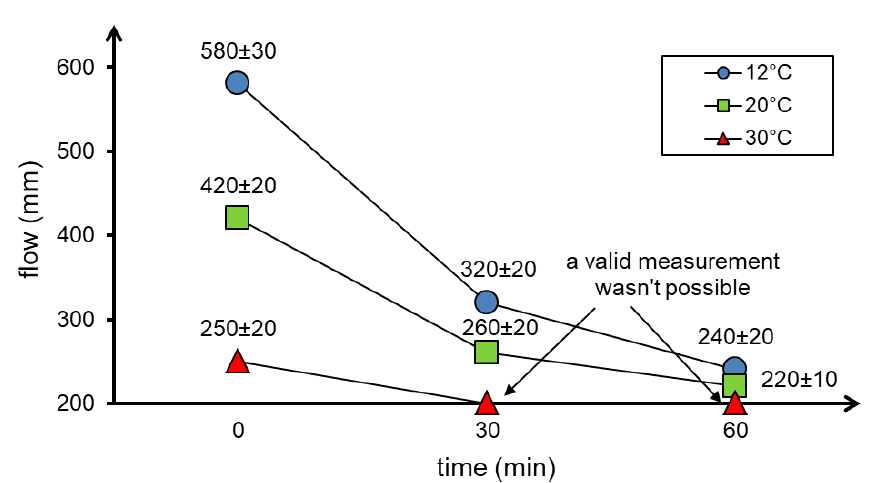
Figure 4. Results of concrete mixture consistency tests with the use of the flow table test depending on the temperature and time of testing.